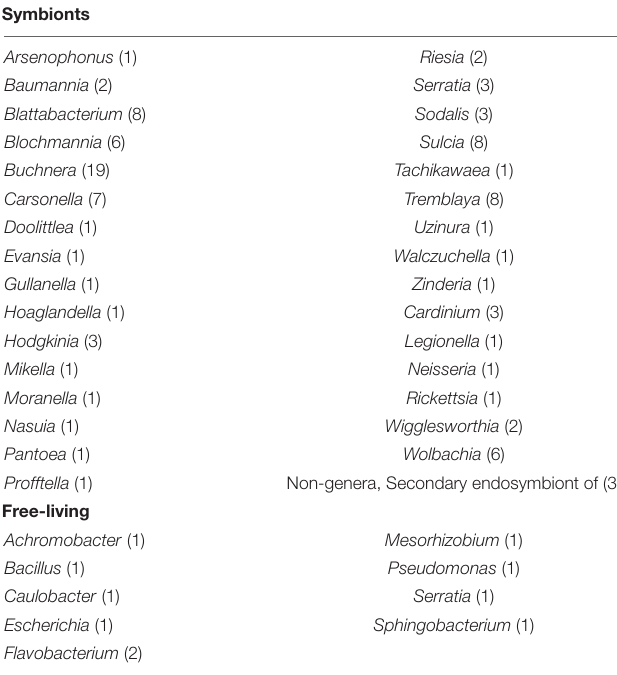
TABLE 1 | Genera of the symbionts and free-living bacteria whose genomes have been used in this study.